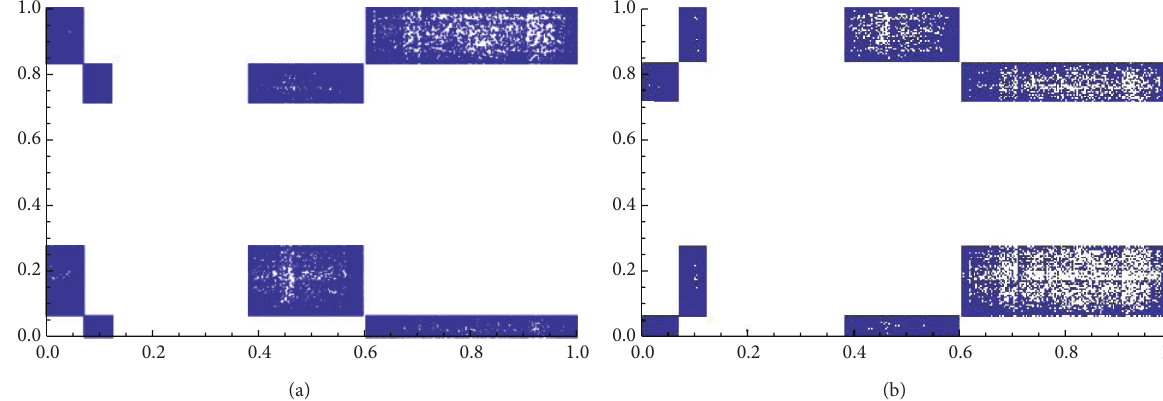
Figure 12: For 𝛼 = 1.3 and 𝛽 = 1.2 we make 200000 iterations and draw the last 100000 in the 𝑋𝑌 axis. We take initial conditions 𝑥 0 = 1/𝛽 in both cases and 𝑦 0 = 0.001 for (a) and 𝑦 0 = (𝑔 𝛽 ∘ 𝑓 𝛼 )(0.001) for (b).